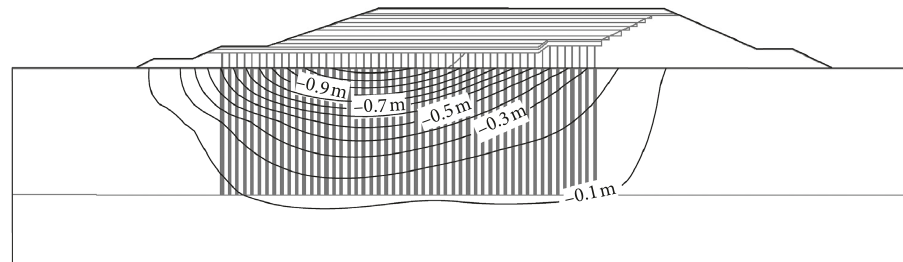
Figure 7: Simulated foundation settlement profile at the end of construction.